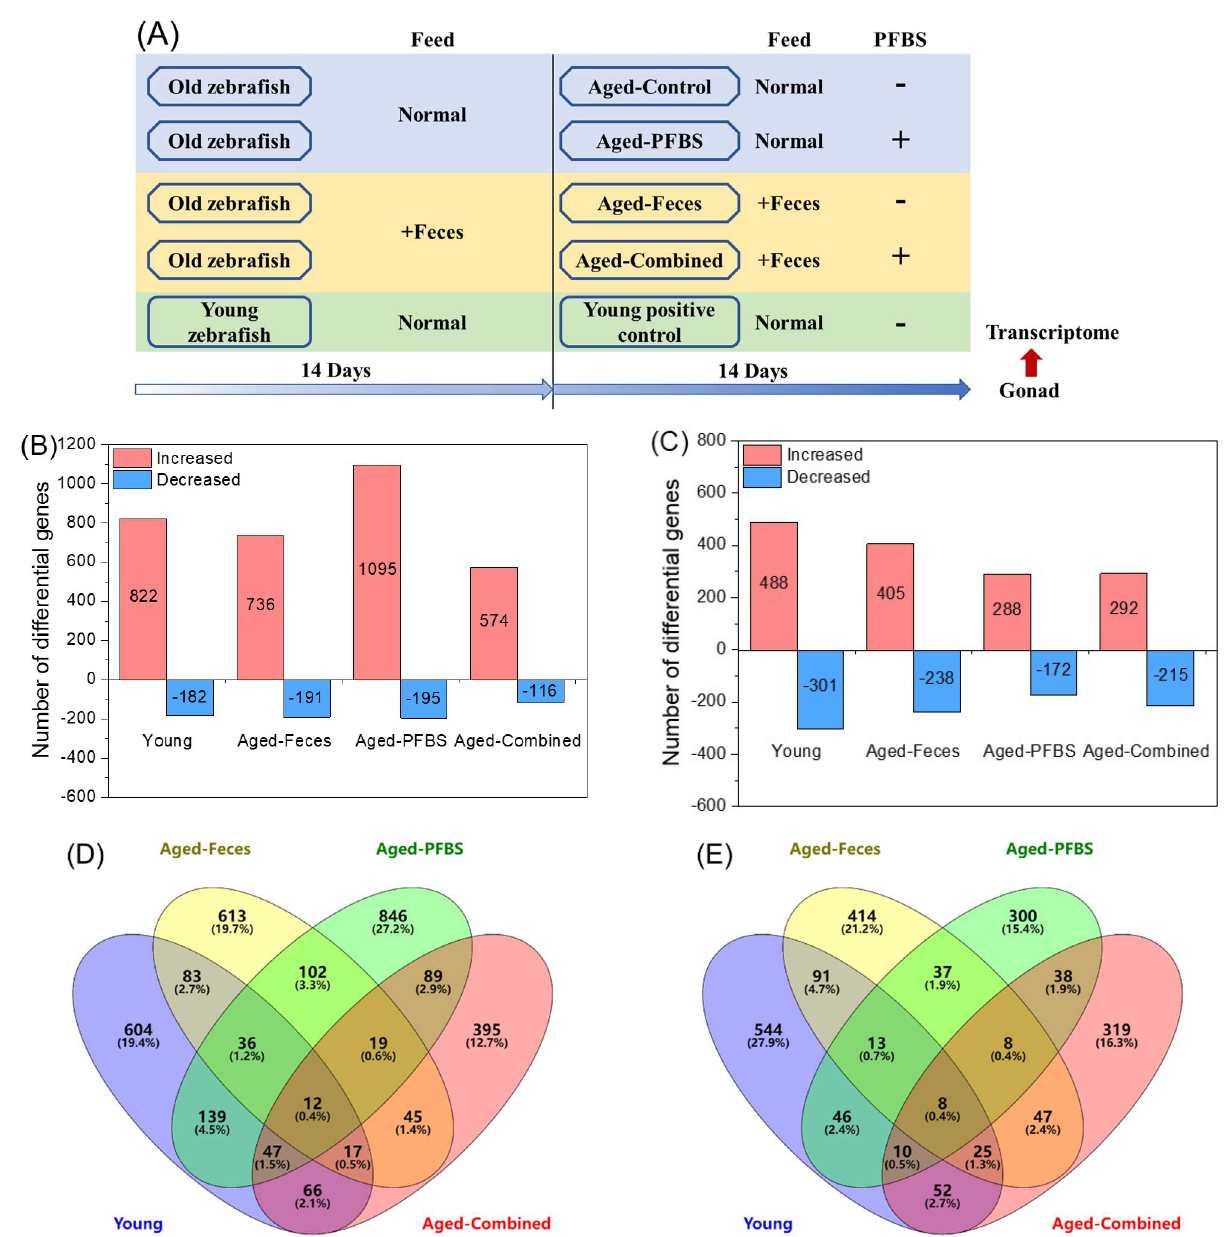
Figure 1. Experimental design ( A ) and a summary of the differential genes in the gonads of zebrafish after exposure to PFBS (0 and 100 µg/L) with or without the transplantation of young donor feces. The number of differential genes of significantly increased or decreased abundance in male ( B ) and female ( C ) zebrafish. A Venn diagram showing the common or unique genes among exposure groups in the male ( D ) and female ( E ). Values are presented as means of three replicates ( n = 3). -, without; +, with. The two different shapes of the boxes indicate old and young fish, respectively (A).